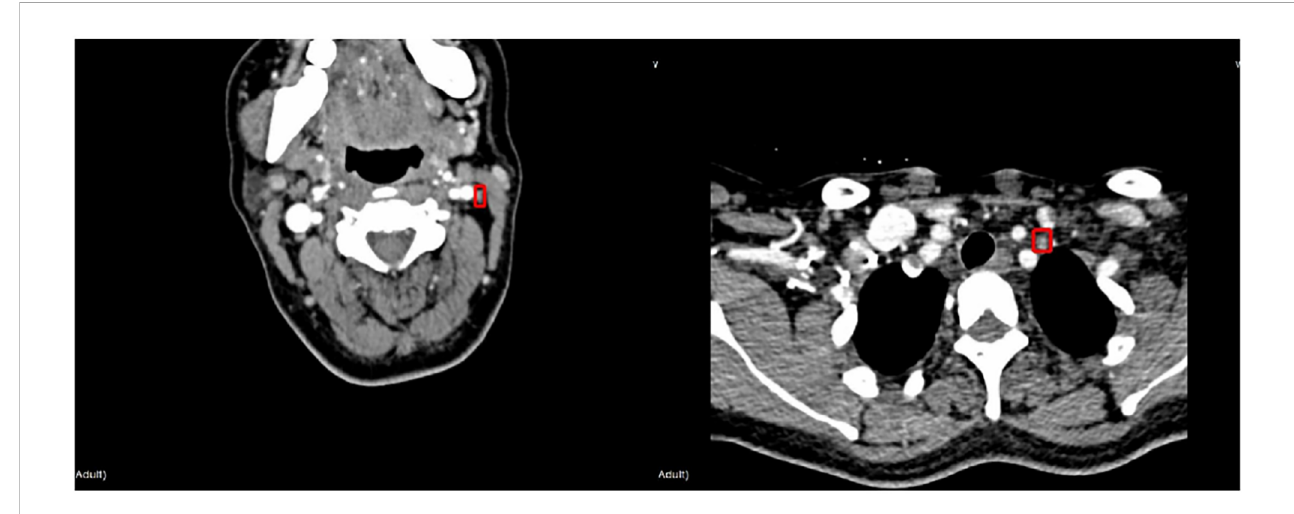
FIGURE 1 Illustration of typical LNMs: Benign case (left), malignant case